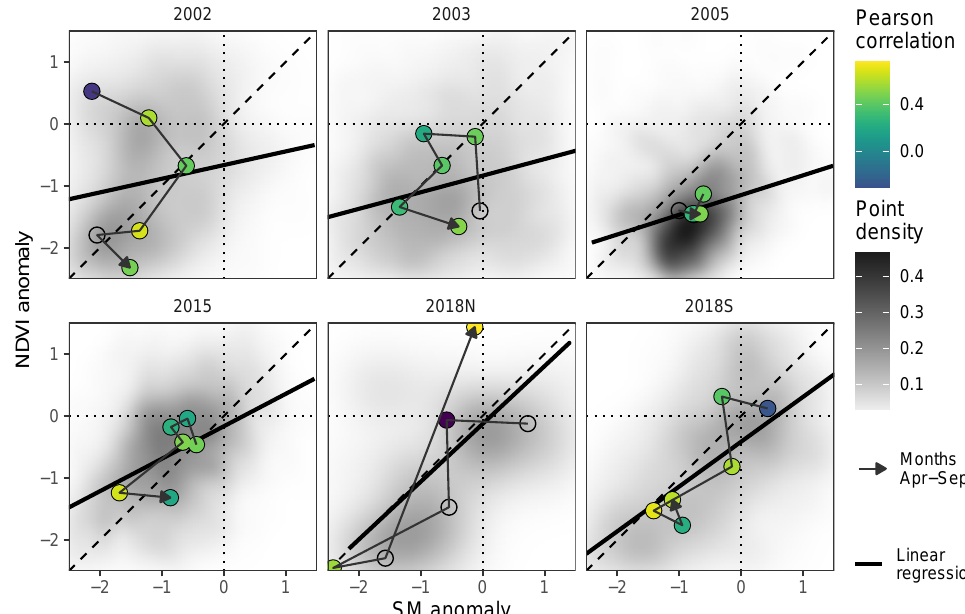
Figure 5. The relations between anomalies in the soil moisture (SM) and vegetation (NDVI). Pan- els show the six drought events, with both soil moisture and vegetation drought defined when the anomaly < − 1. The point density in the background indicates the number of grid cells with a certain combination of anomalies in soil moisture and vegetation. The centroids of each month are chronologically connected with an arrow and shaded by the Pearson correlation in that month if p ≤